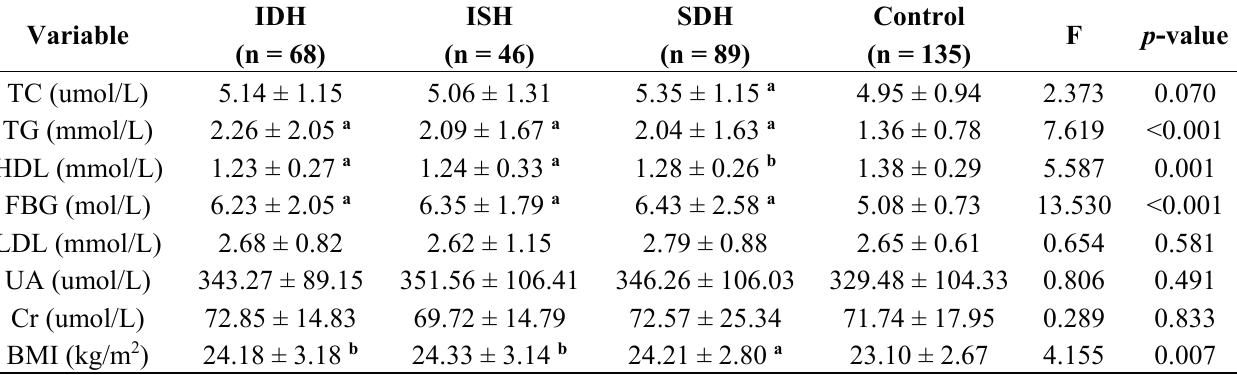
Table 2. Comparison of serum lipid, renal function, blood glucose and BMI of each